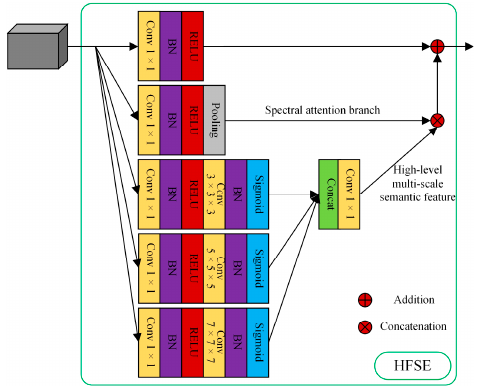
Figure 5. High ‐ level feature semantic enhancement module.